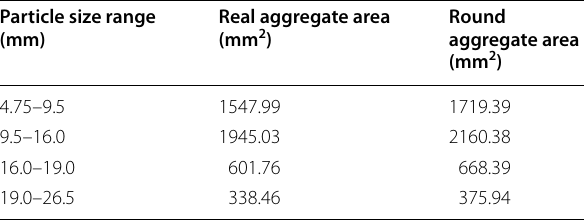
Table 5 Packed coarse aggregate areas at all levels of particle size